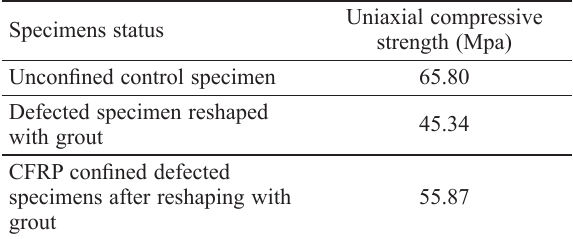
Table 2. Compressive strength of control and repaired